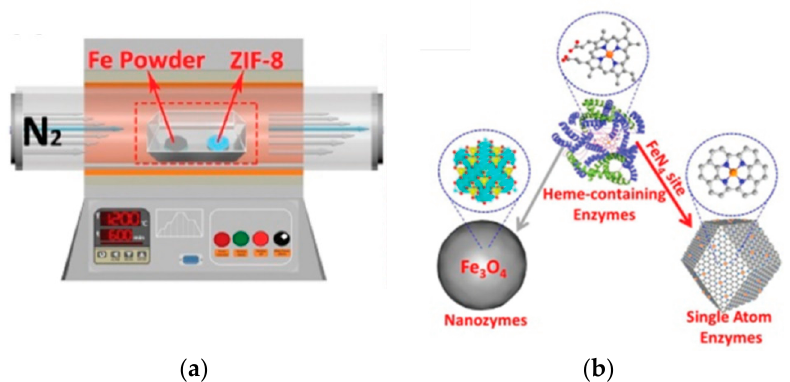
Figure 30. ( a ) Schematic illustration of the synthesis of iron single-atom nanozymes and ( b ) macrostructures and active sites of natural enzymes, nanozymes and iron single-atom nanozymes. (Reprinted with permission from [206] . Copyright © 2019, Royal Society of Chemistry).